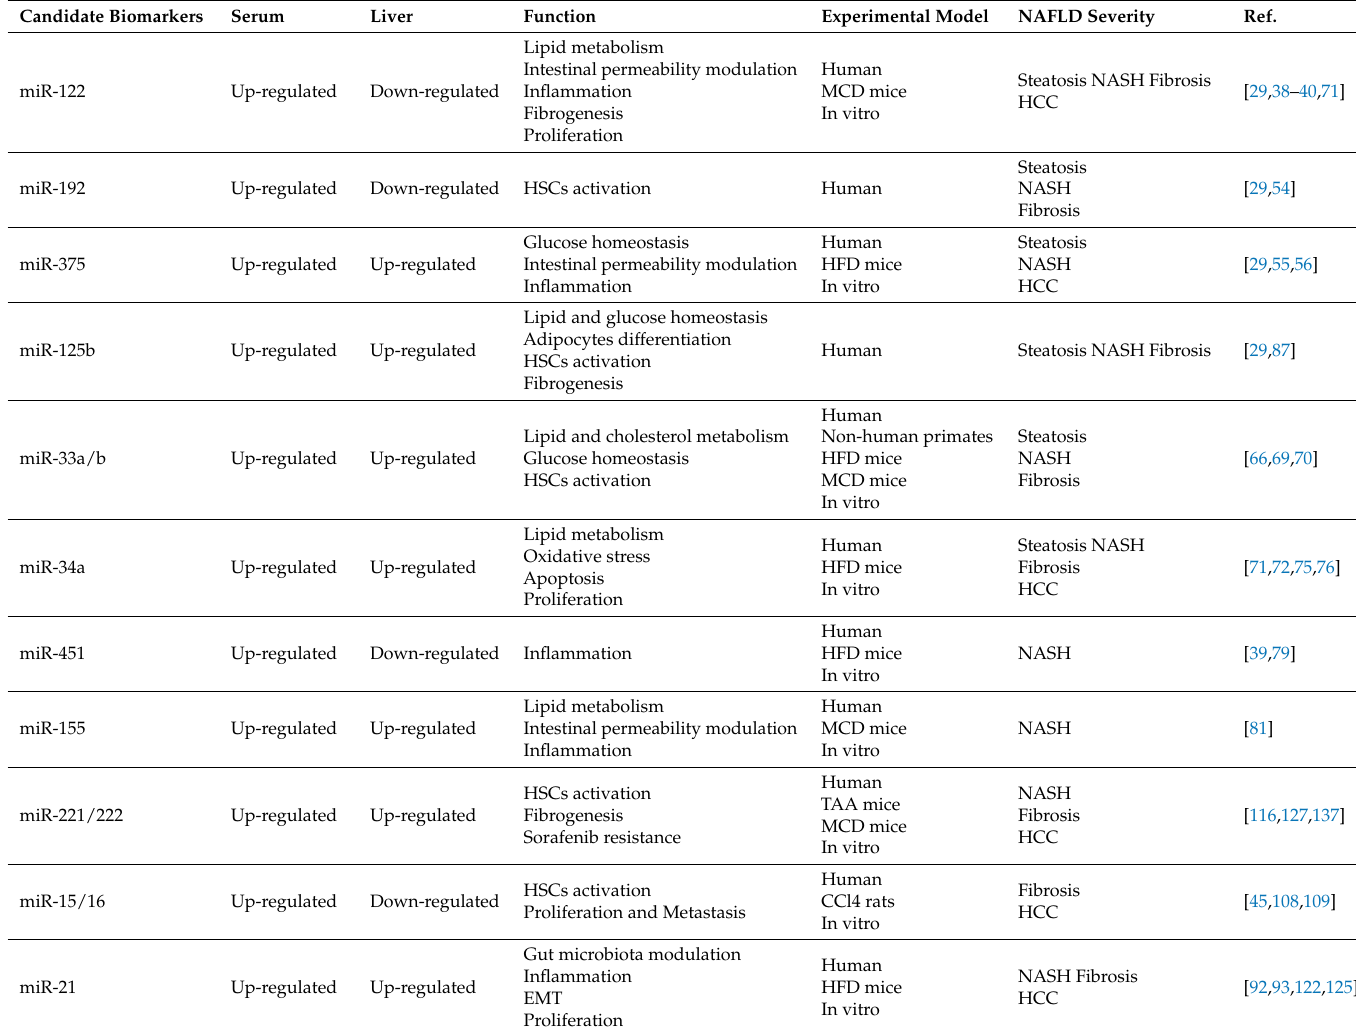
Table 1. List of candidate miRNAs proposed as non-invasive biomarkers, predictors and therapeutic targets in nonalcoholic fatty liver disease